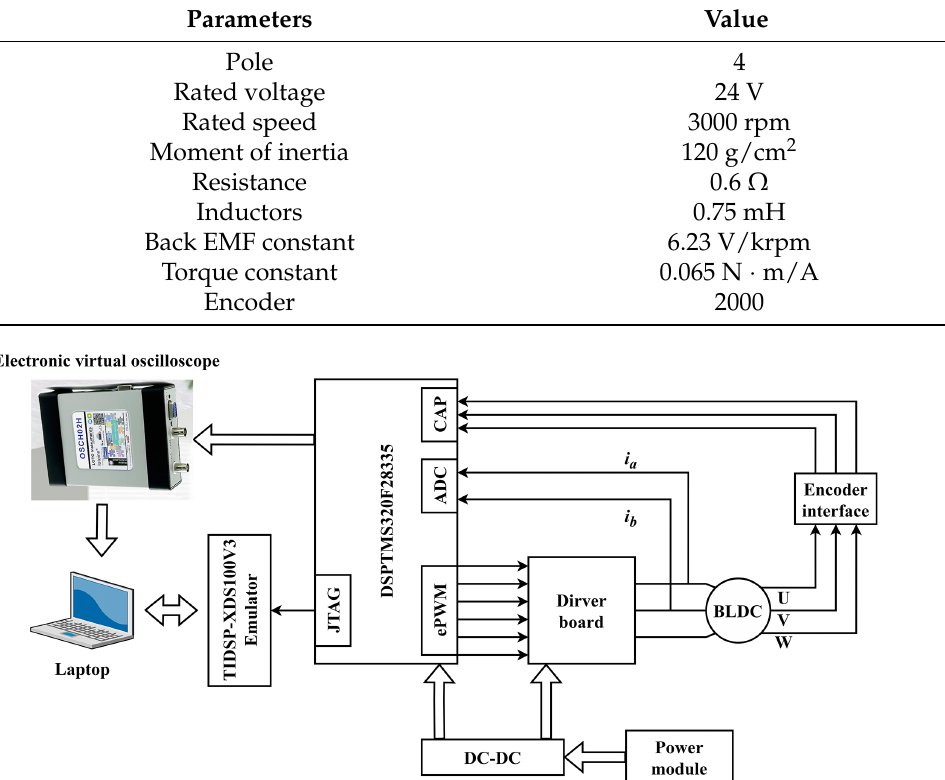
Figure 3. The principle block diagram of experimental setup for the BLDC motor drive